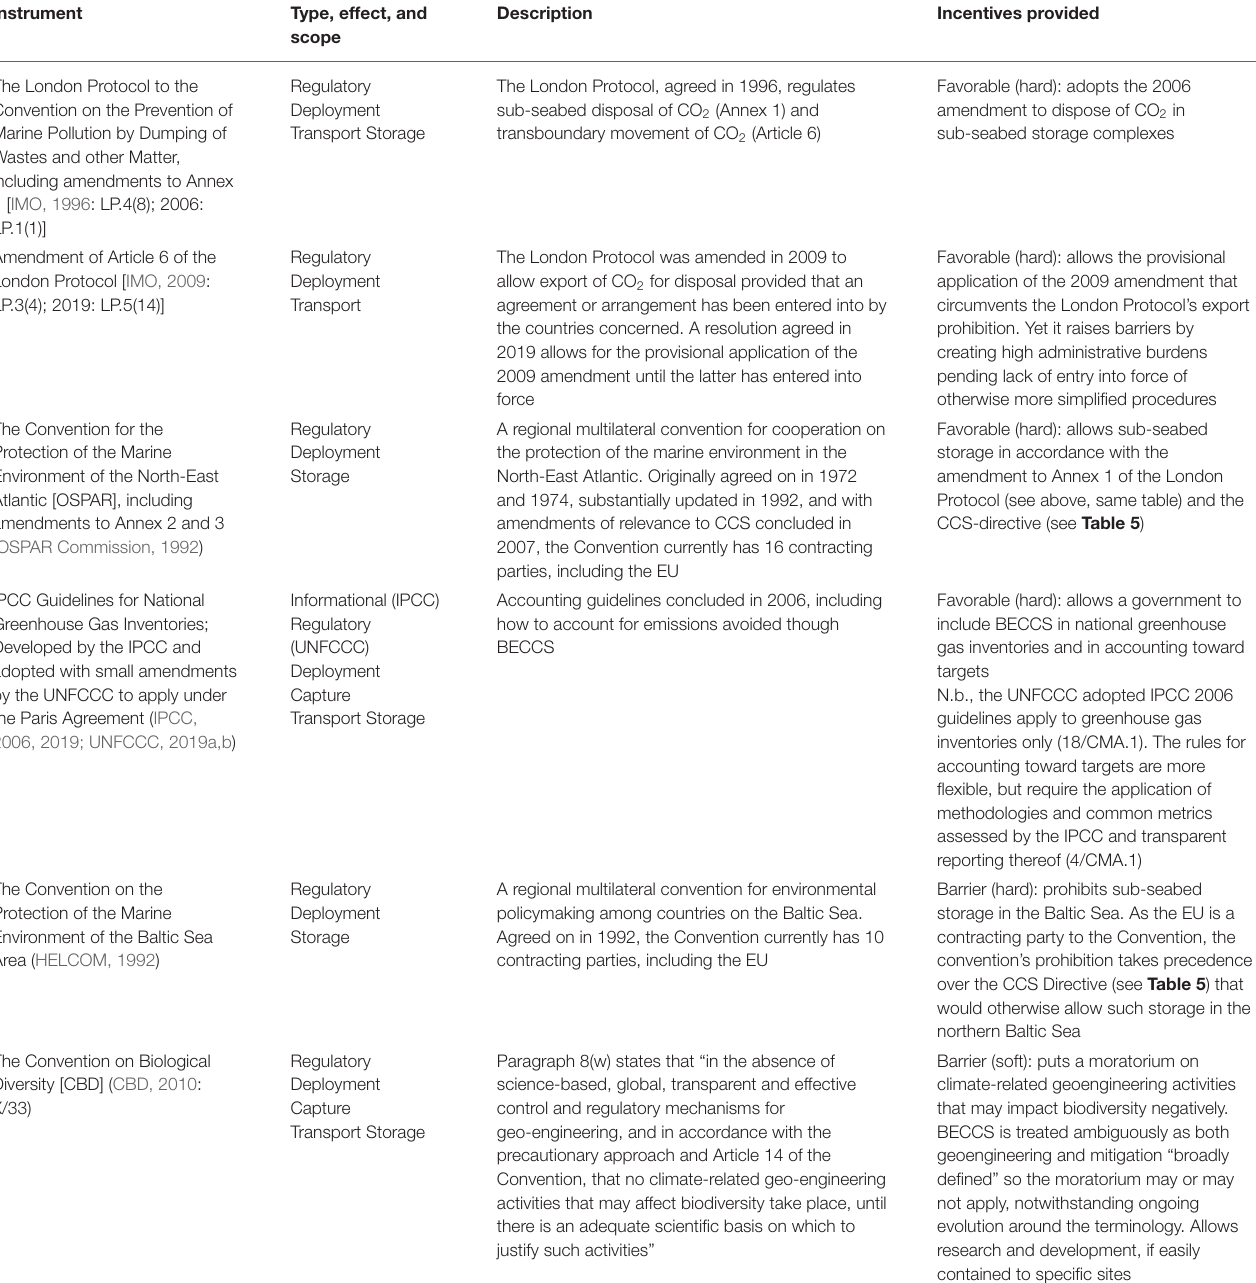
TABLE 3 | International (UN and regional multilateral) regulatory and informational policy instruments of direct relevance to BECCS RDD&D in Sweden, in descending order of significance.